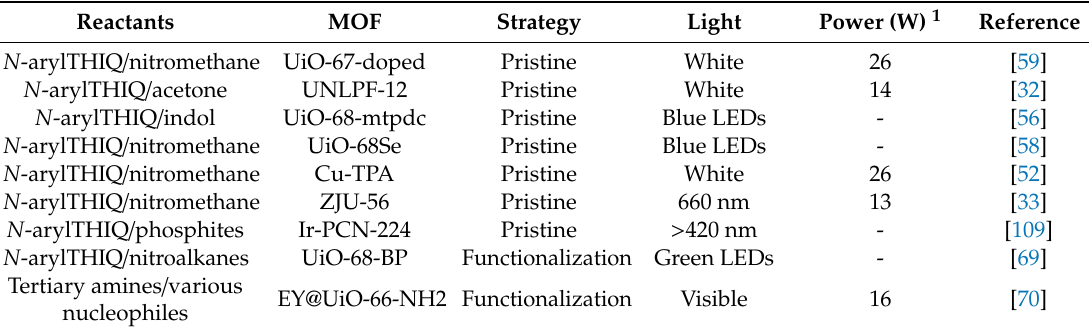
Table 12. Photocatalytic CDC reaction mediated by MOFs.